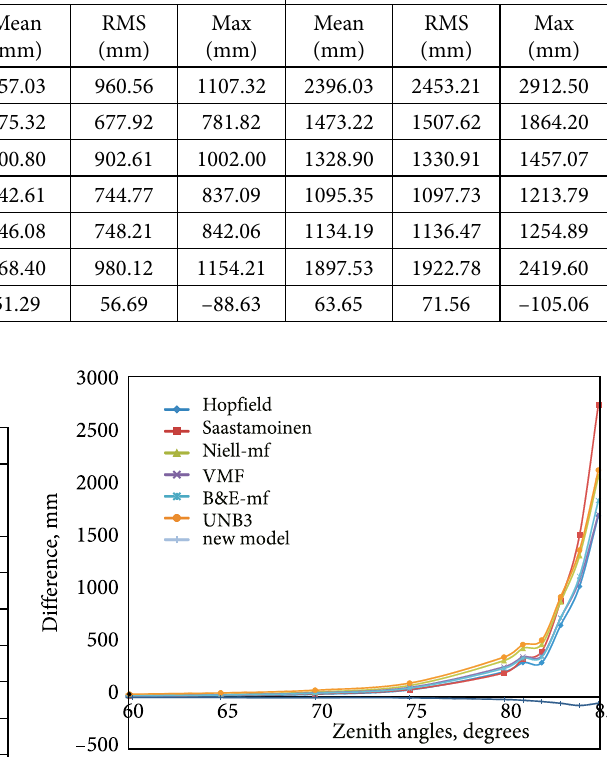
Table 6. Tropospheric delay difference (in mm) between different models and NIM Models